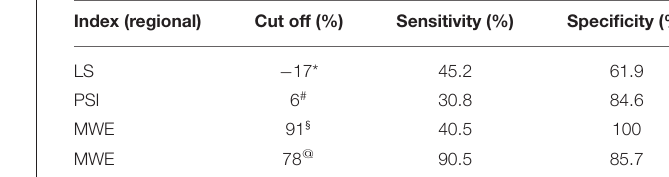
TABLE 3 | Diagnostic performance of regional performance